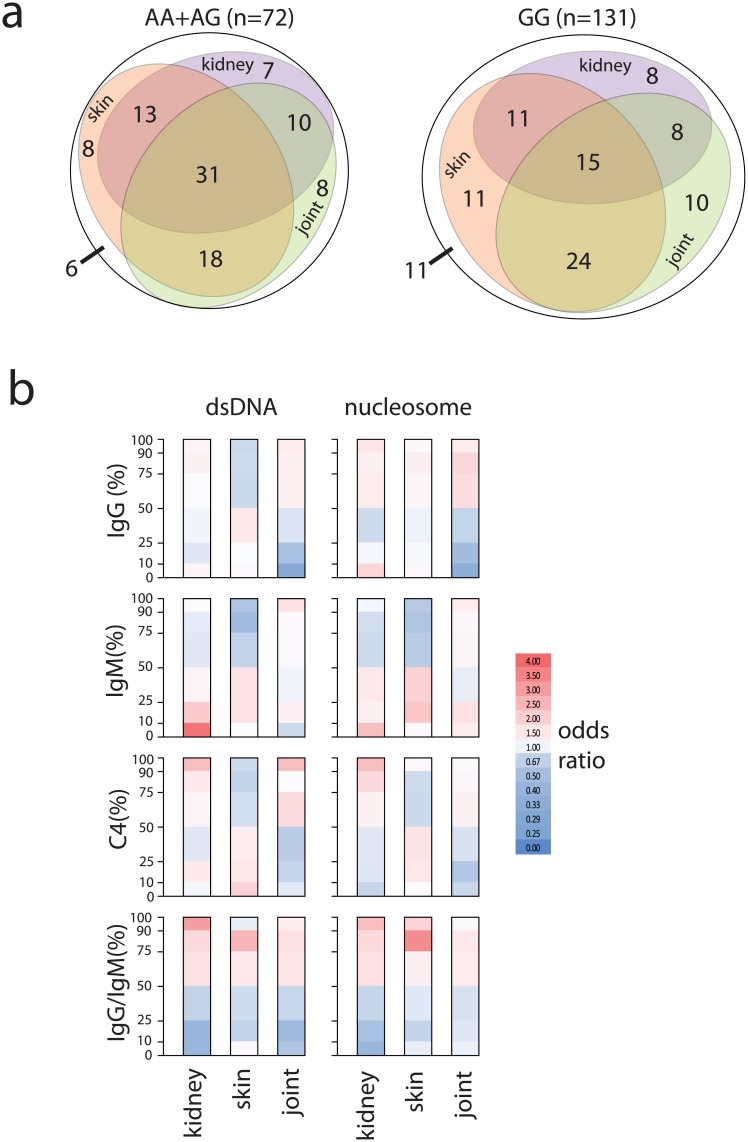
Association of organ involvement with ITGAM genotype and immune complex composition.a. Percentage of the SLE patients with the involvement of the indicated three organs is shown for rs1143679 genotypes. The presence of single, double or triple organ involvement is illustrated by Euler ellipses with areas proportional to the percentages shown. b. Association with organ involvement of the level and composition (IgG, IgM, C4 and IgG/IgM) of immune complexes formed on dsDNA and nucleosome is indicated. Odds ratios for patients falling into the indicated percentile groups (upper 10th, 25th, 50th and lower 10th, 25th, 50th percentiles) for the given measurements are shown. Positive odds (>1) are in red, negative odds (<1) are in blue.